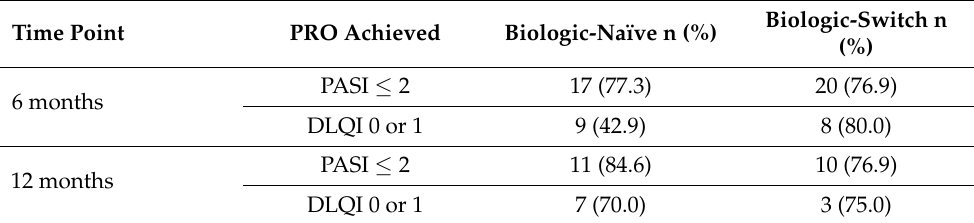
Biologic-Switch n